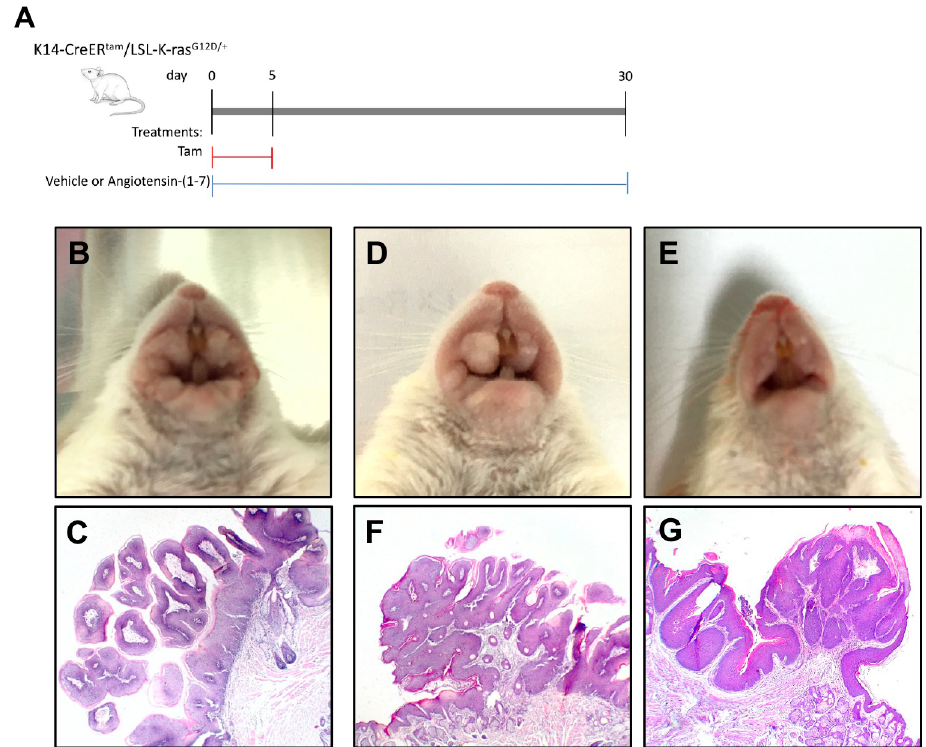
Figure 3. ( A ) Scheme of experimental groups and timeline used in the study. A representative example of K14-CreER tam /LSL-K-ras G12D/+ mice treated with vehicle ( B ) after Tam induction as indicated in the upper scheme. ( C ) Histology of an oral squamous cell papilloma from a K14-CreER tam /LSL-K-ras G12D/+ mouse upon Tam induction and vehicle treatment for 30 days ( n = 4 animals). The hyperplastic epithelium covering thin stromal finger-like projections that grow out of the oral squamous epithelium. Two representative examples of K14-CreERtam/LSL-K-ras G12D/+ mice treated with angiotensin-(1-7) ( D , E ) and the histology ( F , G ) of small oral squamous papilloma from those representative K14-CreERtam/LSL-K-rasG12D/+ mice upon Tam induction and angiotensin-(1-7) treatment during 30 days ( n = 6 animals). Original magnification: X4.